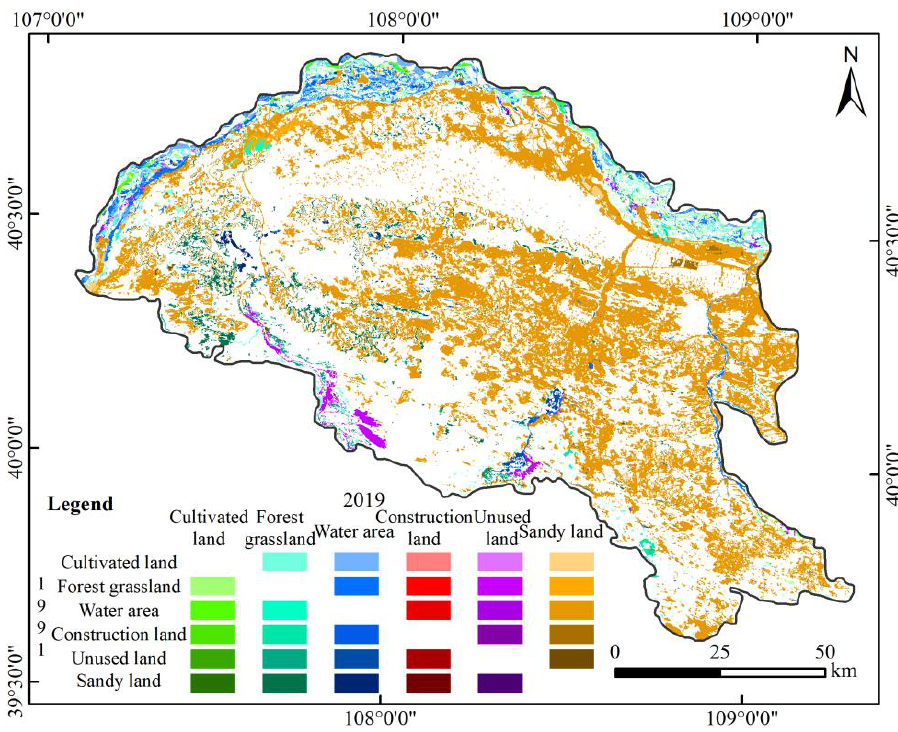
Figure 4. The land-use transfer changes along the Yellow River section of the Hobq Desert from 1991 to 2019.